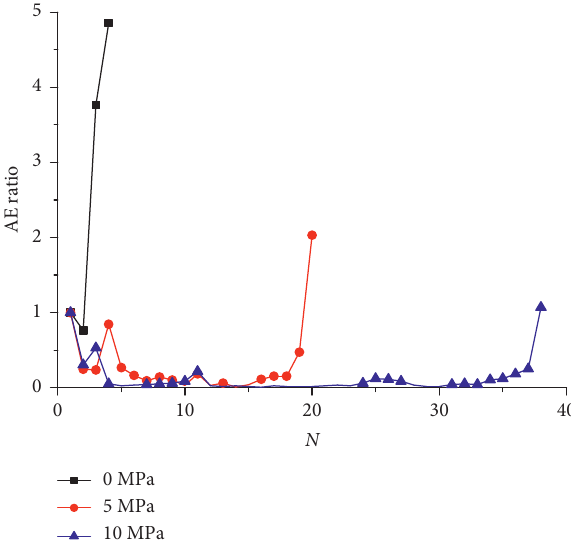
Figure 6: Cumulative AE count curves per cycle under different confining pressures. Figure 7: AE ratio versus cycle number